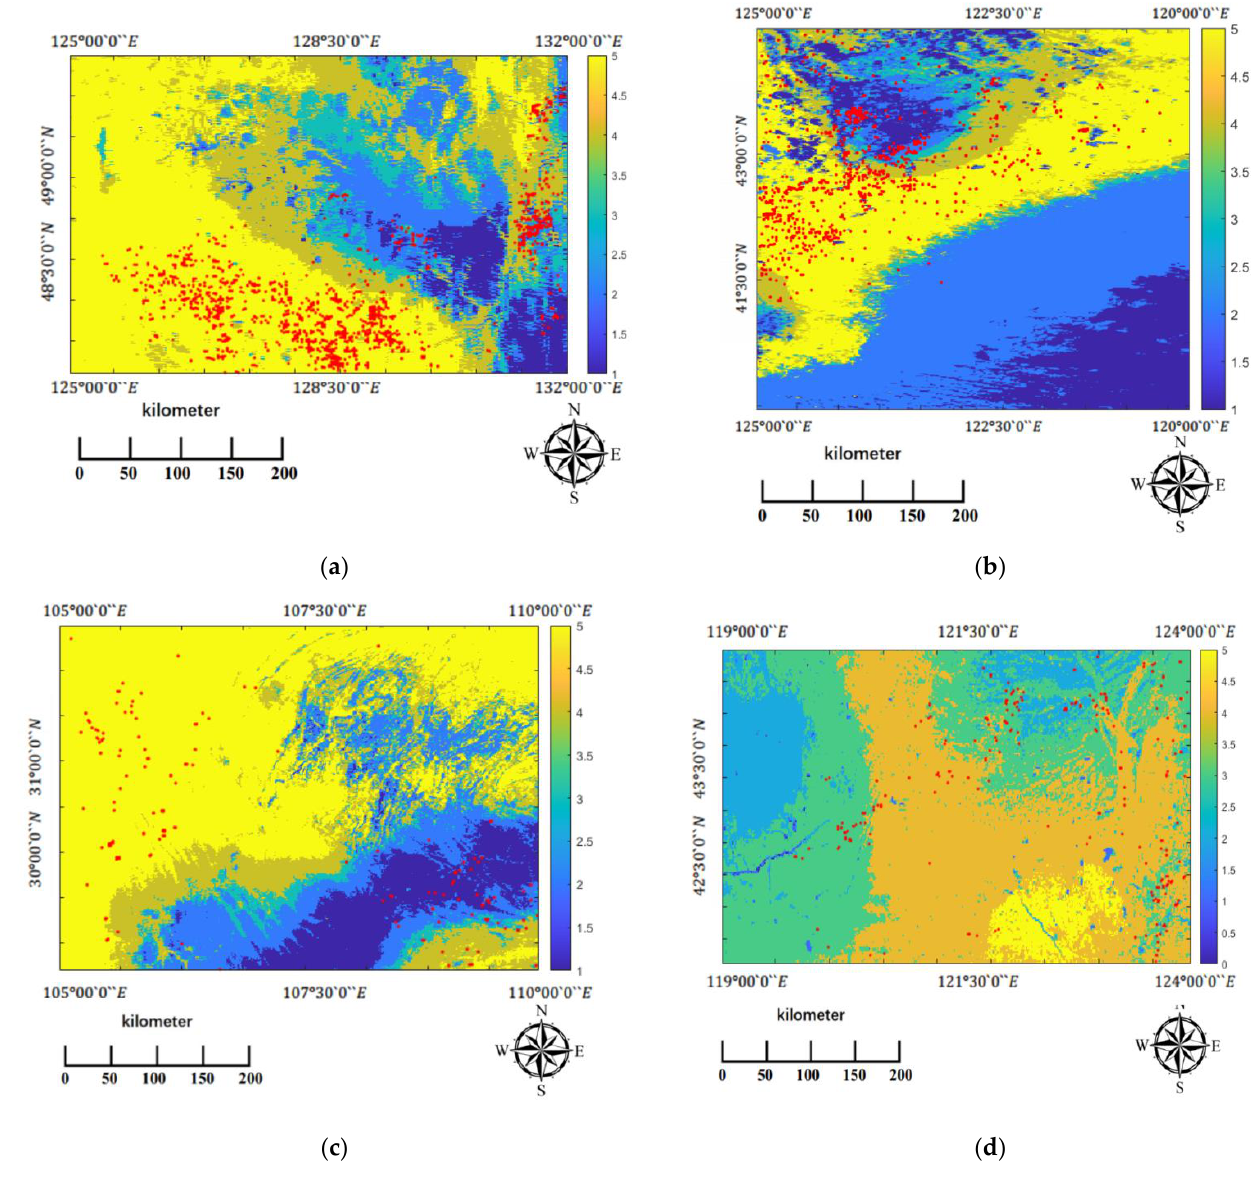
Figure 5. Forest fire danger rating map constructed by the SVM regression model using monthly precipitation data: ( a ) forest area in the southern Greater Khingan Mountains; ( b ) forest area near Hulunber city; ( c ) forest area near Chongqing city; ( d ) forest area near Tongliao city.